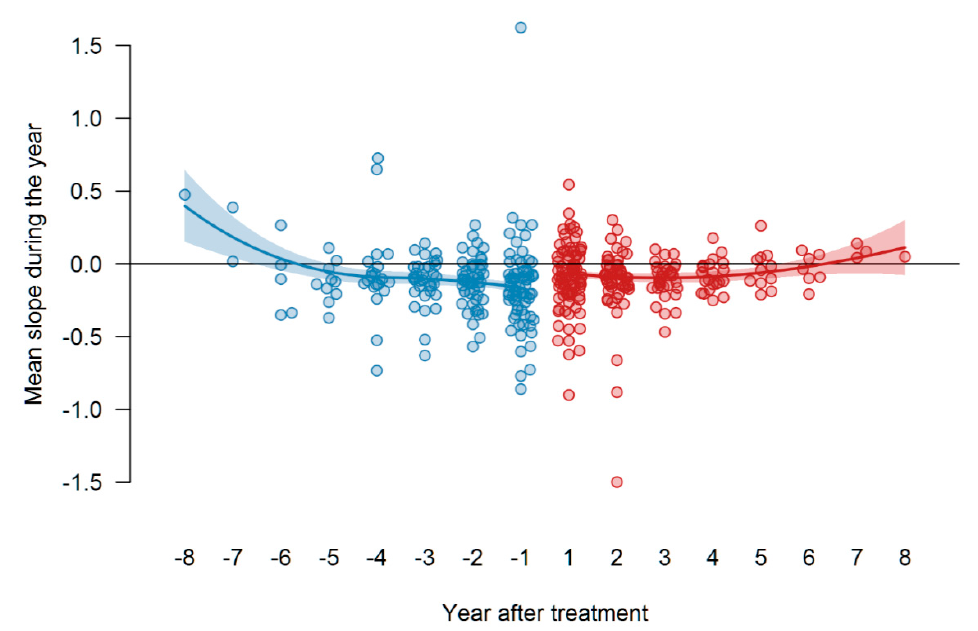
Figure 8. Therapy response to pirfenidone as measured by differences in the FVC slopes before and after t0 . Figure 8 shows the values of FVC (in liters), blue dots represent values before t0, red dots — values after t0 (start of therapy). In addition, the points for the annual changes in the years before t0 are now also drawn. The year “0” is missing on the x-axis, the year “ − 1” is the change from year − 1 to year 0 (=t0) (i.e., the period of the first year before t0), and the year “1” is the change from year 0 to year 1 (i.e., the period of the first year after t0).